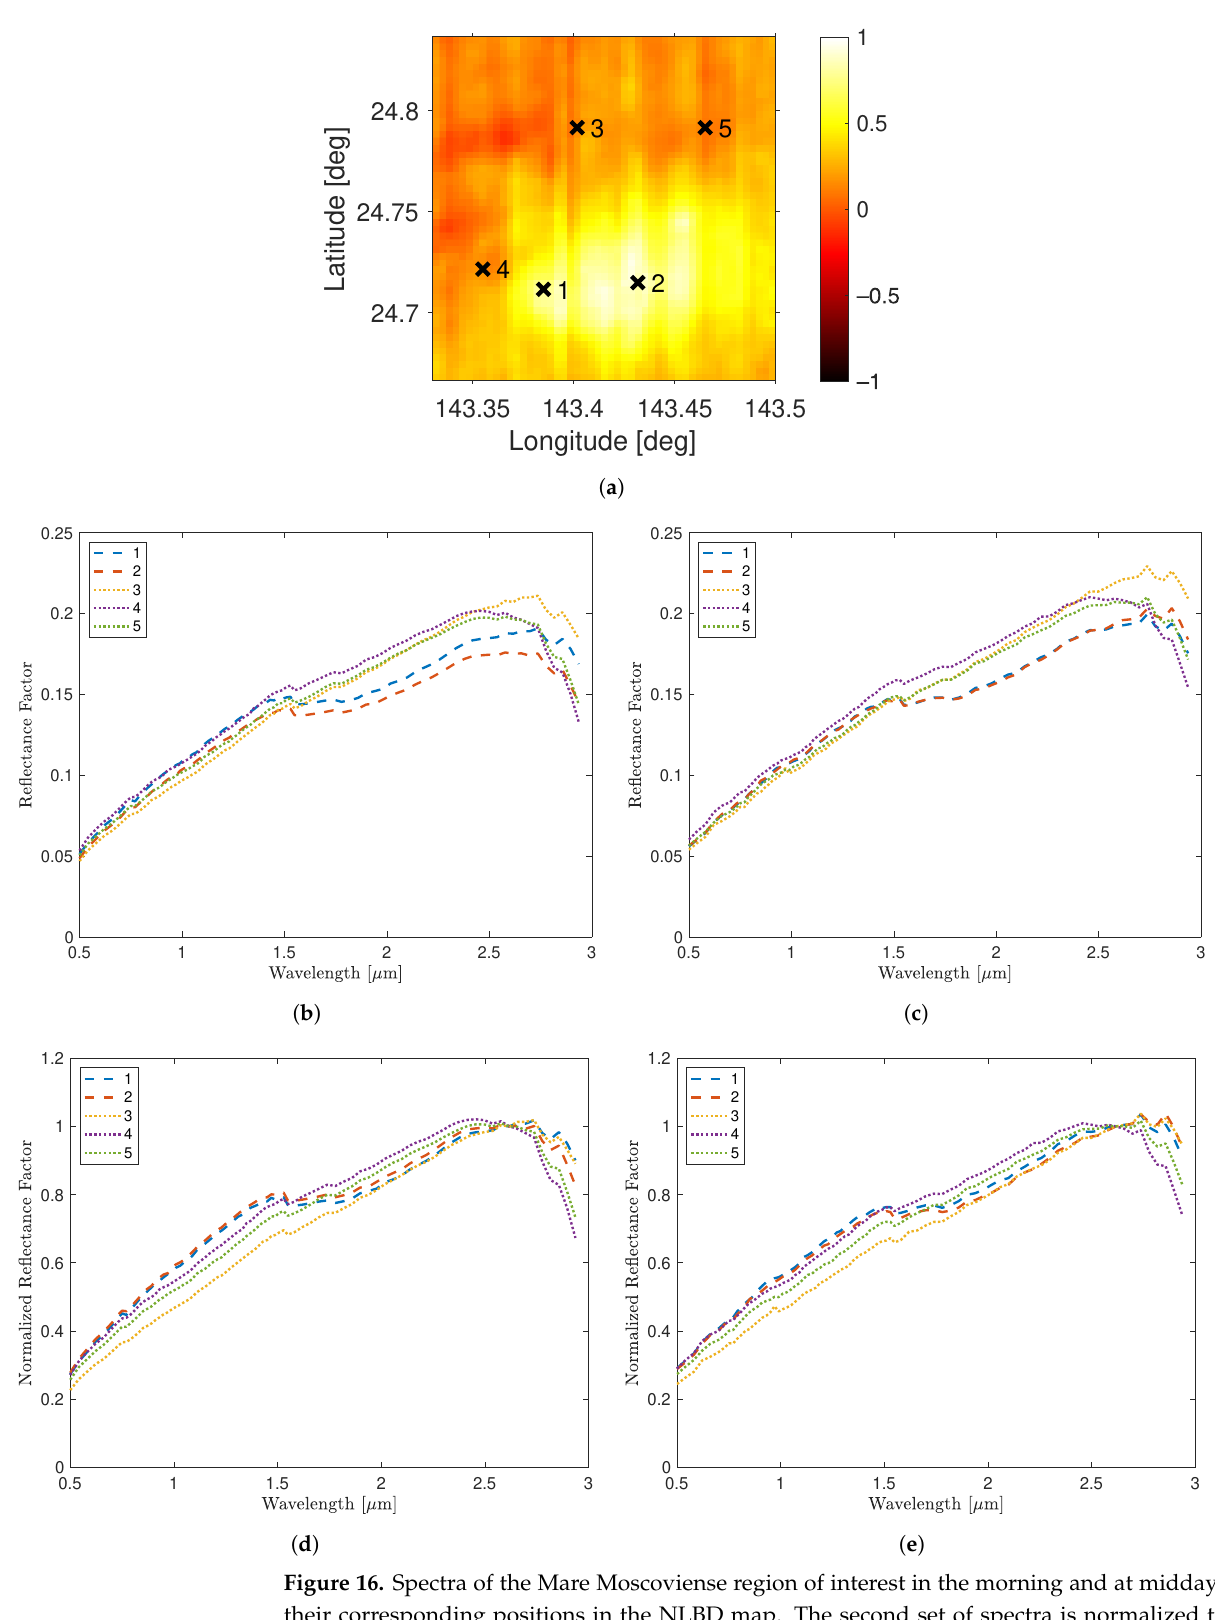
Figure 16. Spectra of the Mare Moscoviense region of interest in the morning and at midday, and their corresponding positions in the NLBD map. The second set of spectra is normalized to the reflectance at 2.617 µ m (M 3 channel 76). ( a ) Positions of example spectra, ( b ) at 09:20 local time, ( c ) at 11:15 local time, ( d ) at 09:20 local time, normalized, ( e ) at 11:15 local time,